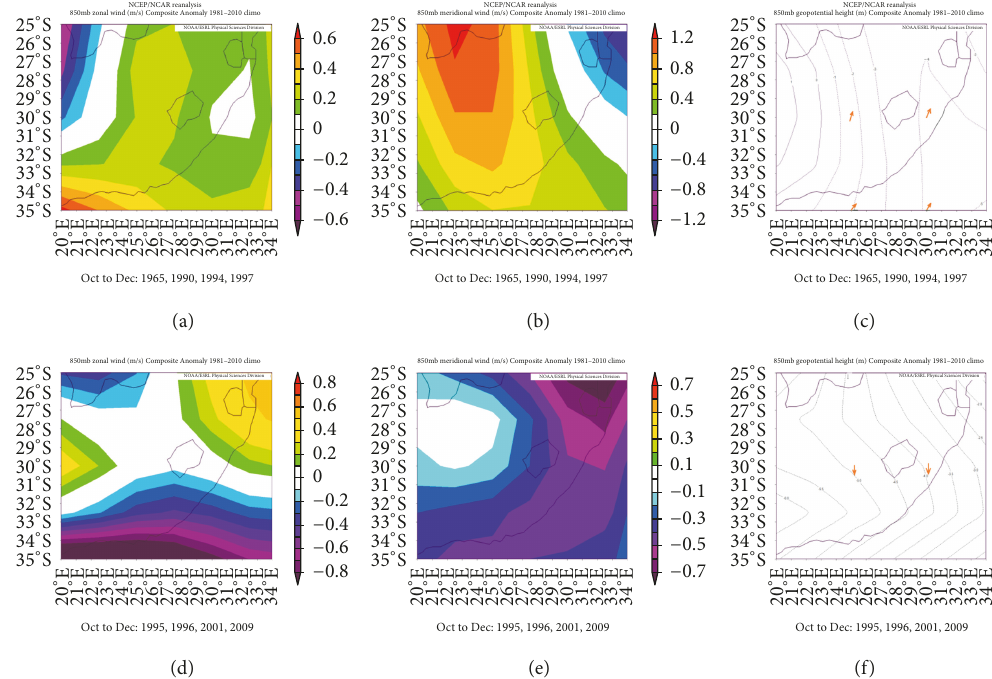
Figure 7: Zonal, meridional, and geopotential height anomalies for droughts (a), (b), and (c) and wet events (d), (e), and (f), respectively. Scalar winds are indicated in (c) and (f) with the years constituting the composites shown in the inserts. Corr Oct–Dec averaged FSP OND SPI 1 index with Oct–Dec averaged ERA–int taux 1979 :2012